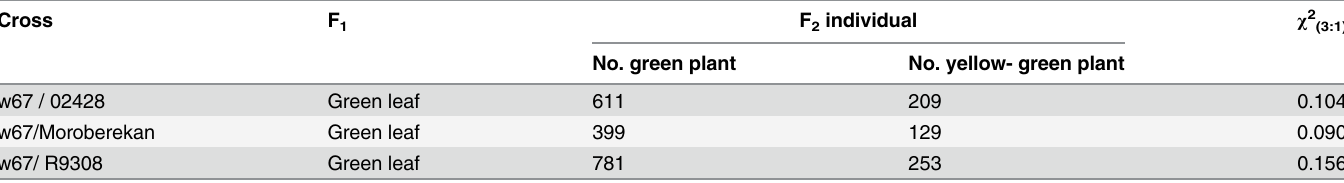
Table 4. Genetic analysis of the yellow-green phenotype in w67.